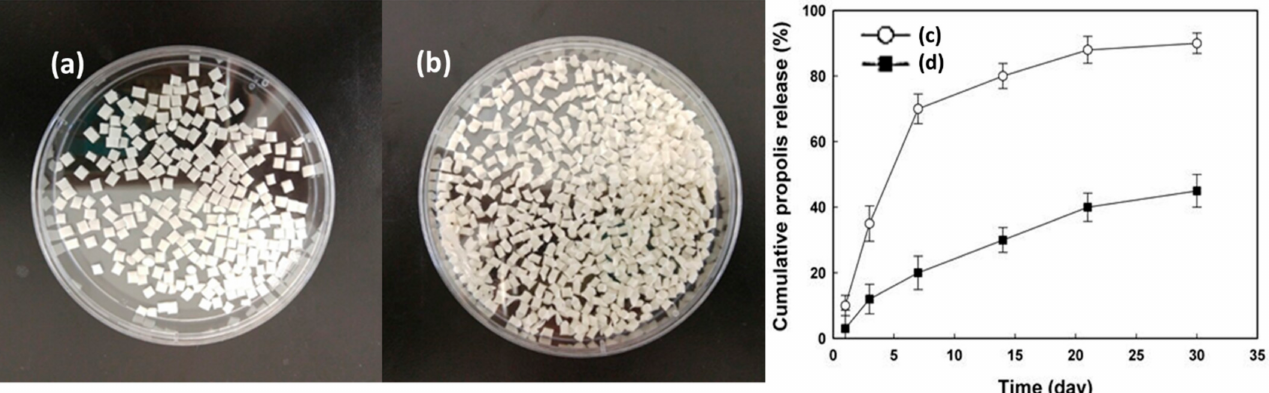
Figure 3. PLA/PCL pellets complexed with propolis-embedded zeolite nanocomposites: ( a ) PLA/PCL pellets; ( b ) PLA/PCL pellets complexed with propolis-embedded zeolite nanocomposites. Drug release from propolis-embedded zeolite nanocom- posites ( c ) and PLA/PCL pellets complexed with propolis-embedded zeolite nanocomposites ( d ).